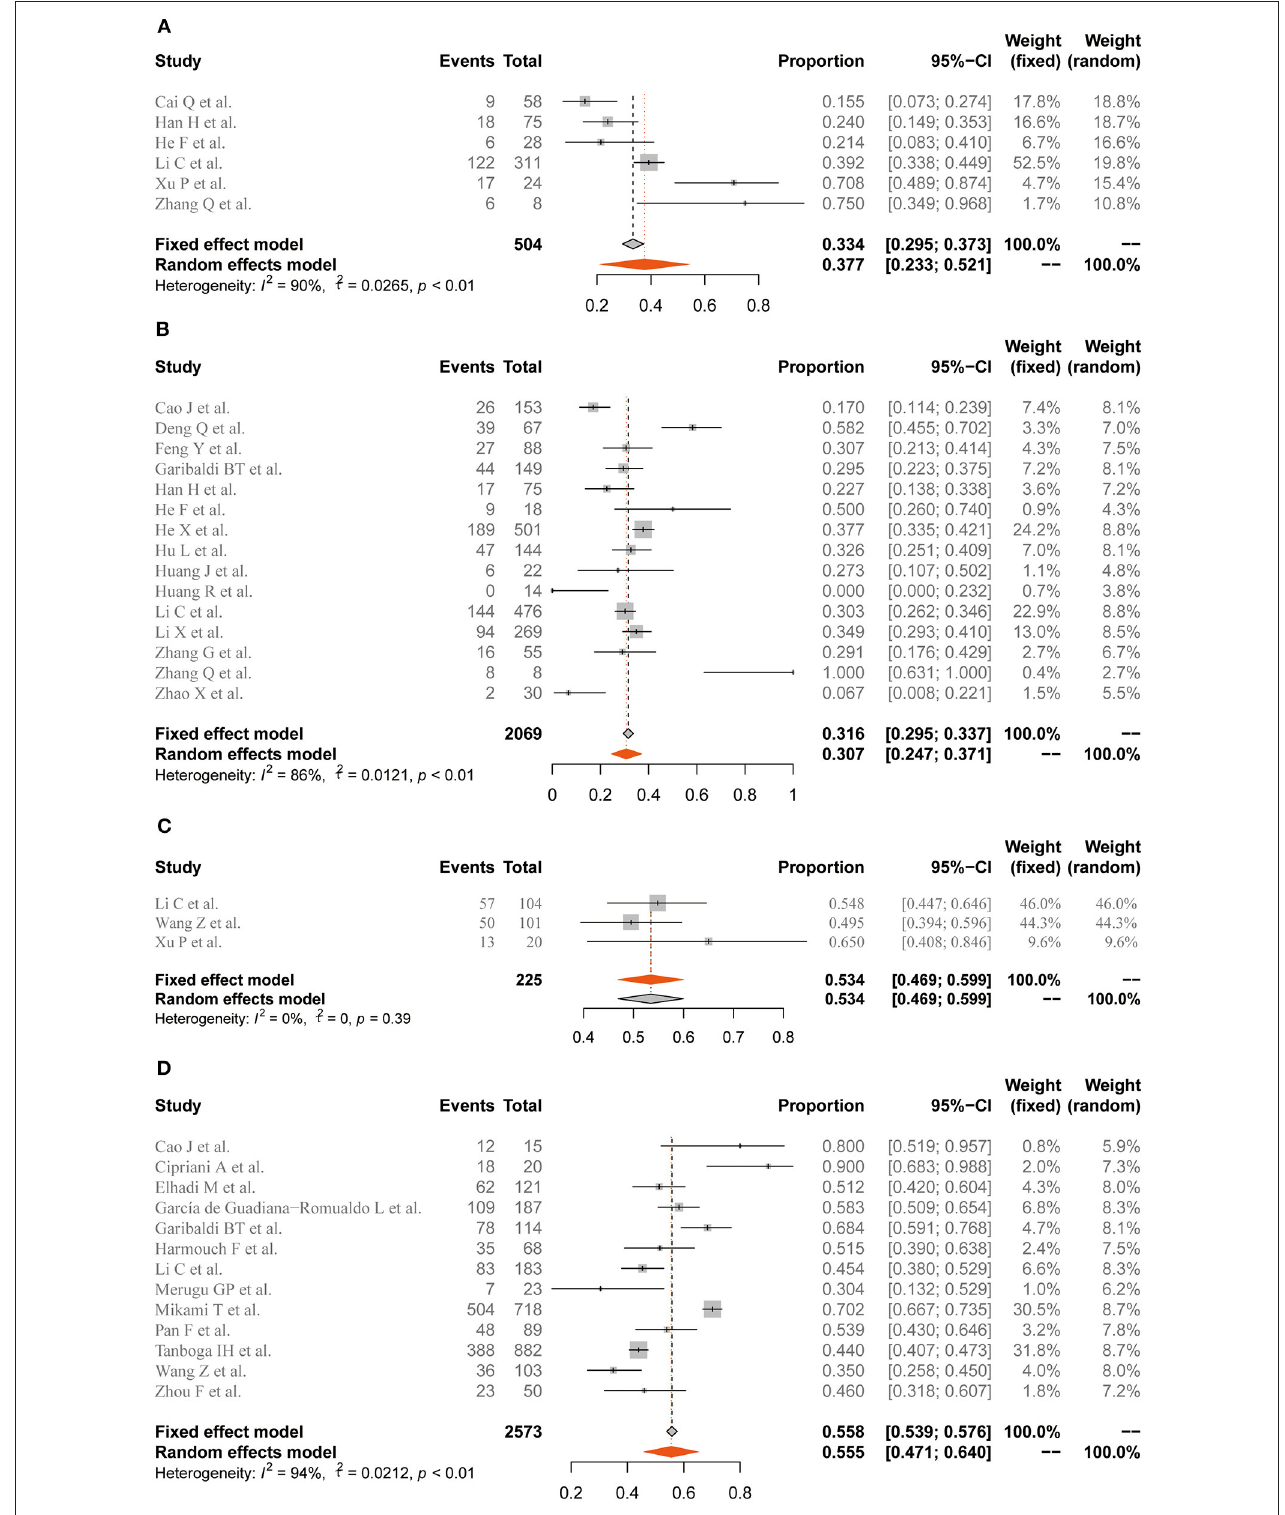
FIGURE 3 | Forest plot for the pooled prevalence of elevated Mb and cTnI in the severe disease and non-survivor groups. (A) Prevalence of elevated Mb in the severe disease group. (B) Prevalence of elevated cTnI in the severe disease group. (C) Prevalence of elevated Mb in the non-survivor group. (D) Prevalence of elevated cTnI in the non-survivor group. Mb, myoglobin; cTnI, cardiac troponin I. Proportions are presented with fixed-effects when I 2 ≤ 50% and random-effects otherwise.